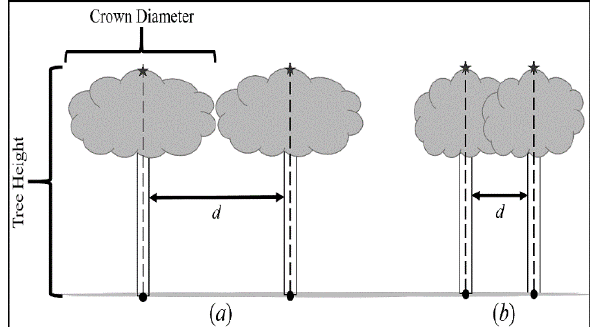
Figure 4. Not interlocking tree crowns (a), interlocking tree crowns (b). 𝑑 is the distance between two tree stems. As seen in the figure, the distance between tree tops is smaller when tree crowns are